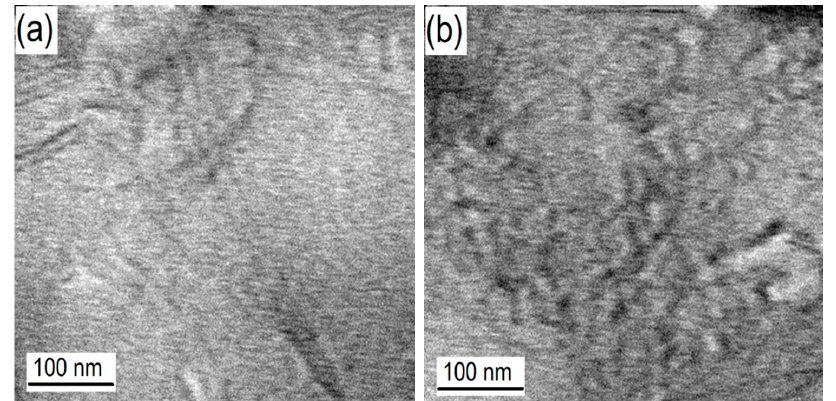
Figure 3. Transmission electron microscopy (TEM) micrographs of ( a ) PCNT and ( b ) FCNT after vapor phase treatment.